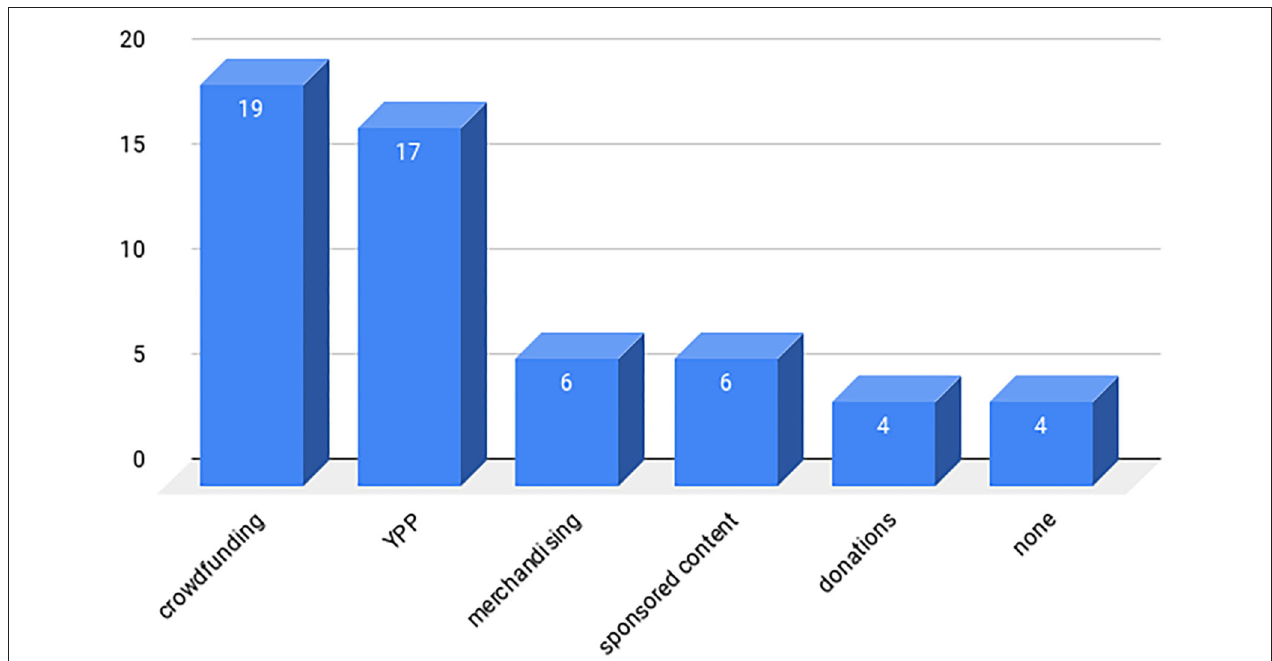
FIGURE 7 | Financial support of science YouTubers.